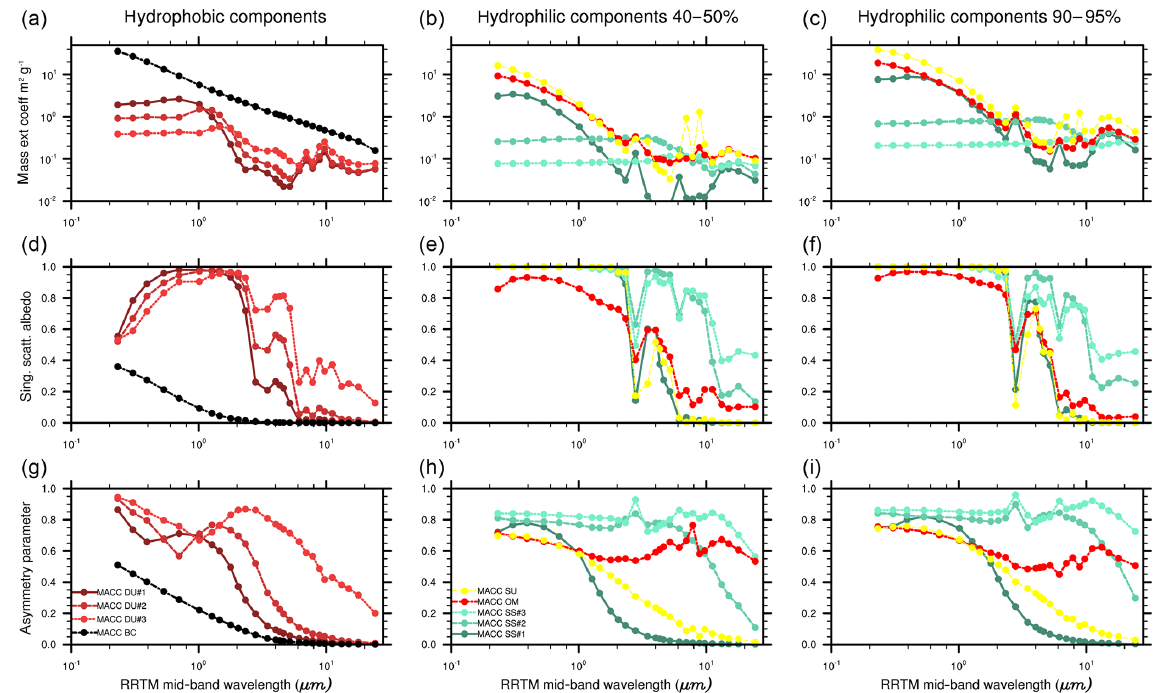
Figure A2. Optical properties of the aerosol species in the CAMS model for the 30 spectral bands of the ECMWF radiation scheme. For the hydrophilic species the mass extinction coefficient is computed with respect to the dry aerosol mass. Panels (a) – (c) show the mass extinction coefficient, and (d) – (f) show the single scatter albedo and panels (g) – (i) show the asymmetry parameter. Panels (a) , (d) and (g) are for the hydrophobic species, and (b) , (e) , (h) , (c) , (f) and (i) are for the hydrophilic species at two values of RH.